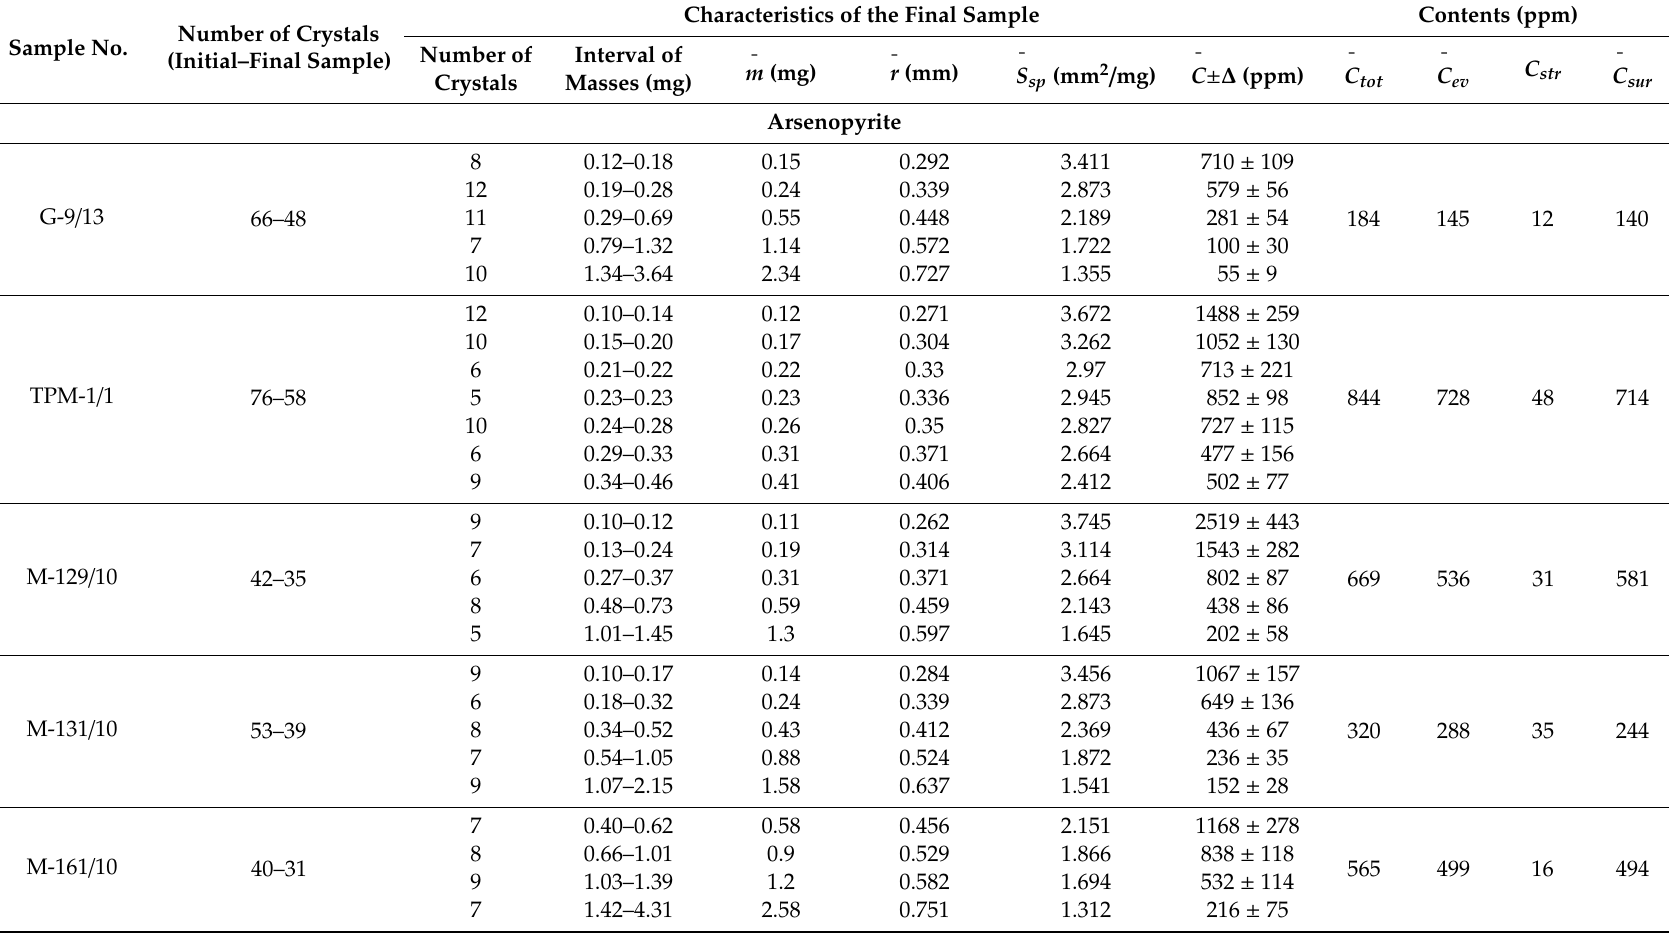
Table 3. Results of platinum analysis of single crystal size selections of arsenopyrite and pyrite from vein, streaky-vein and veinlet-disseminated ores of the Natalkinskoe